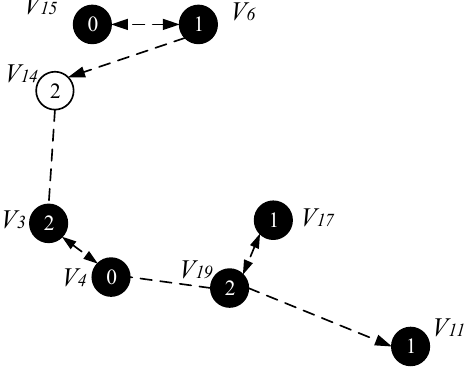
Figure 19. Preliminary broadcast backbone of AAS-LBR scheme.